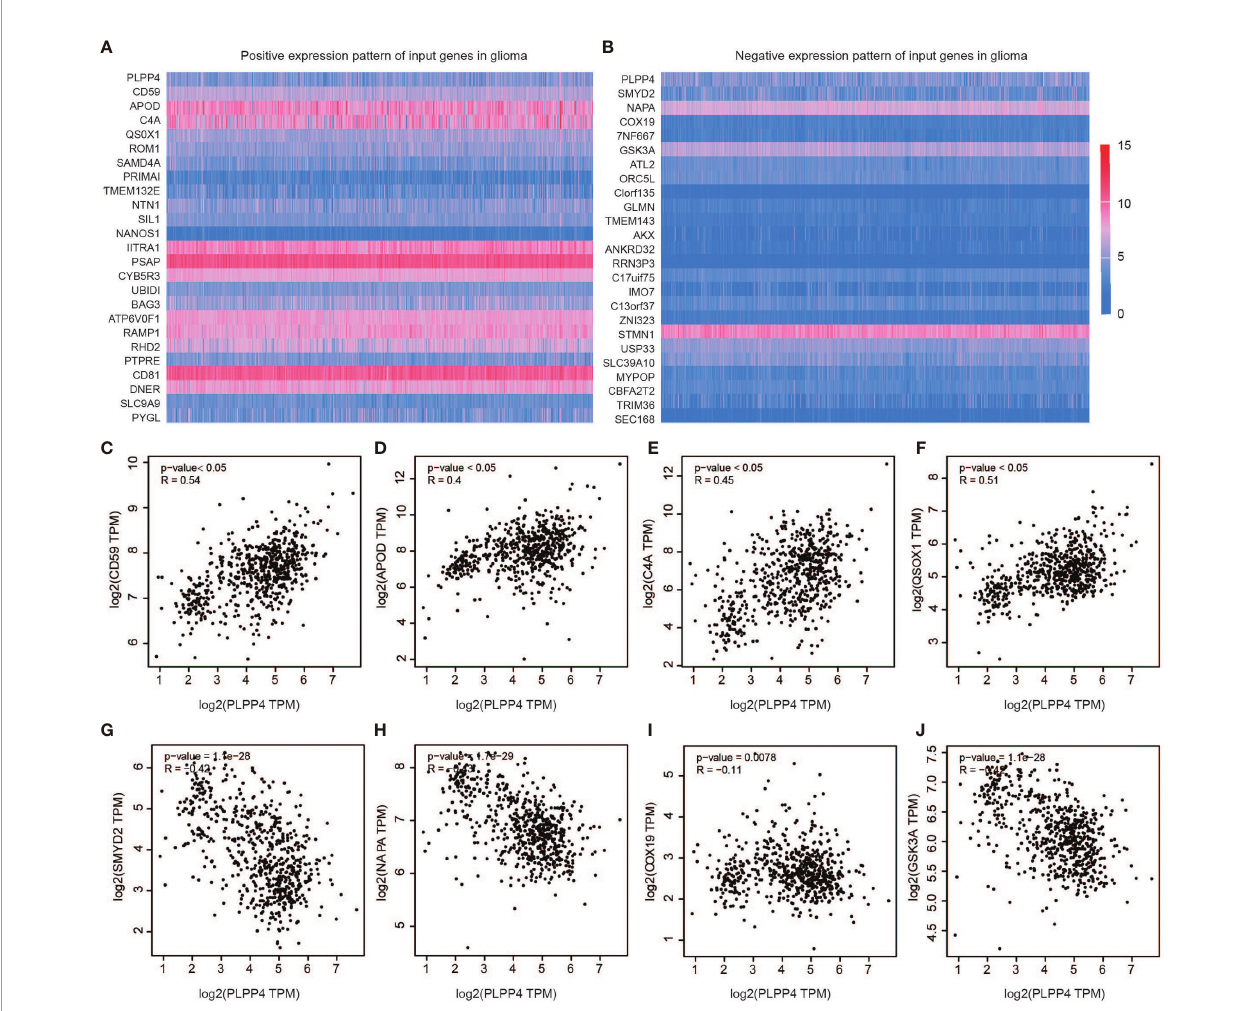
FIGURE 9 | Genes correlated with PLPP4 in glioma. (A) Genes positively correlated with PLPP4 in glioma (B) Genes negatively linked with PLPP4 in glioma. (C – F) Positive correlation analysis between PLPP4 and other genes (CD59, APOD, C4A, QSOX1). (G – J) Negative correlation analysis between PLPP4 and other genes (SMYD2, NAPA, COX19,